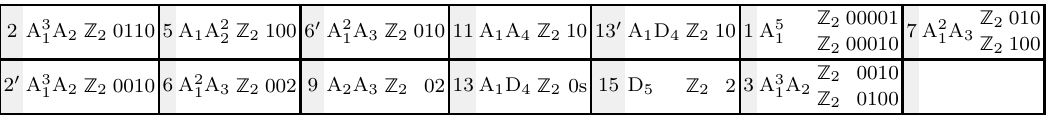
Table 12 . Groups of maximal rank with non-trivial fundamental group and their generators for the heterotic Z 4 triple.